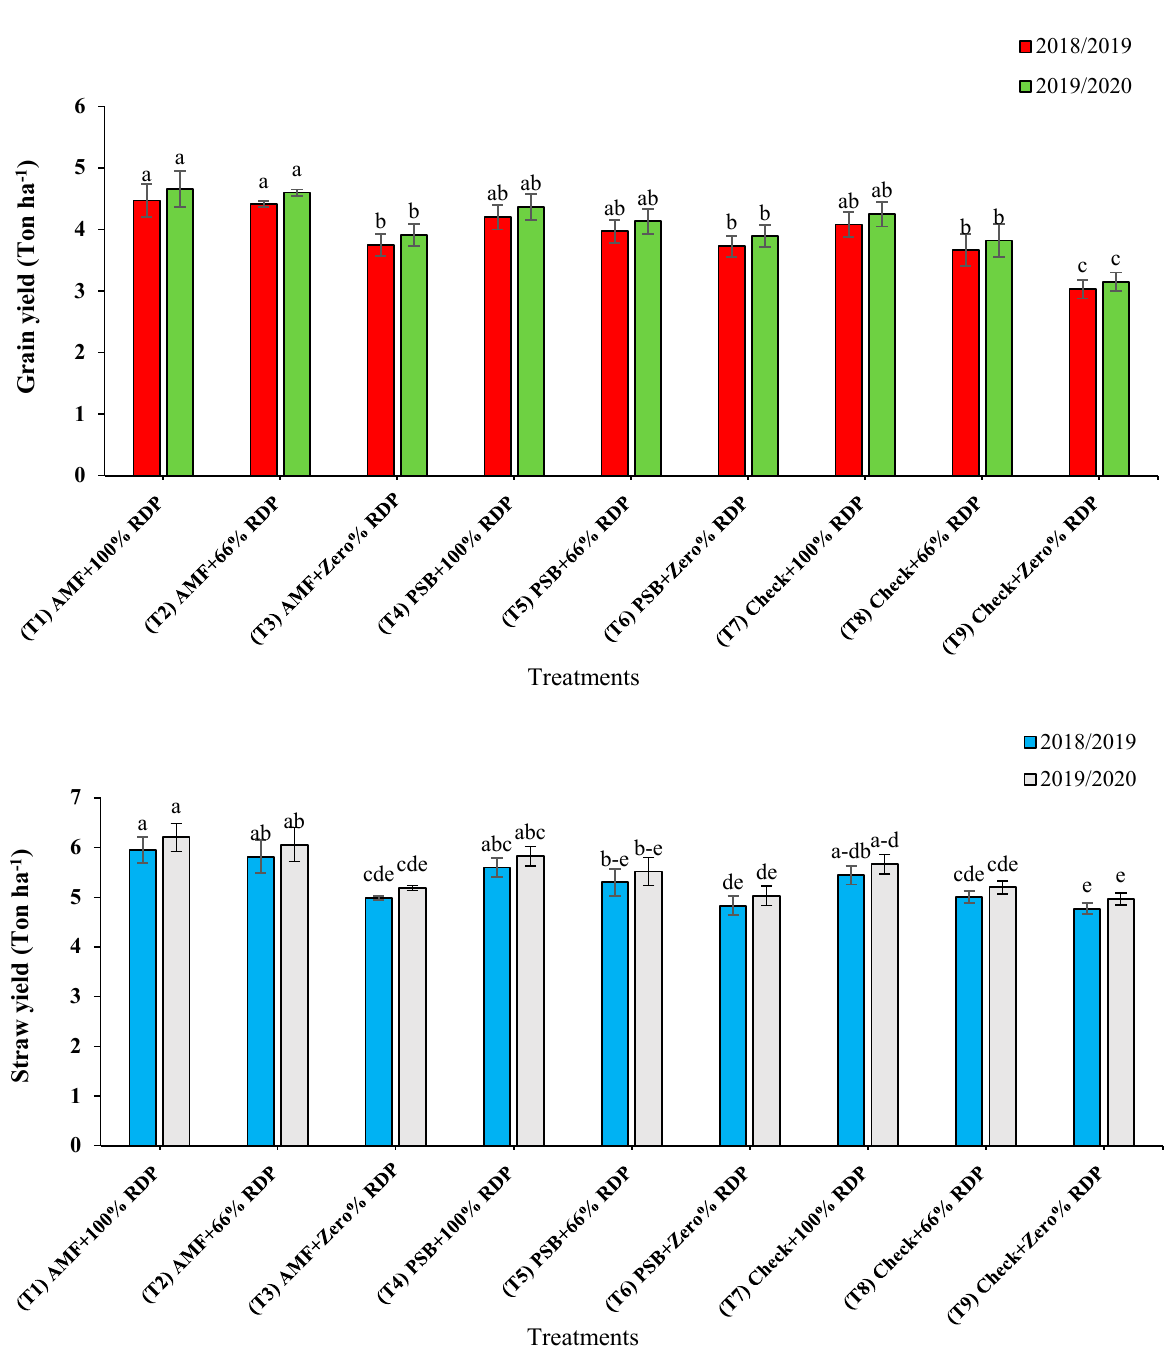
Figure 1. Grain and straw yield (Ton ha − 1 ) of barley Giza 123 cultivar were influenced by the treatment of arbuscular mycorrhizal fungi (AMF), phosphate-solubilizing bacteria (PSB), and different percentages of the recommended dose of phosphorus fertilizers (RDP) in the 2018/2019 and 2019/2020 seasons. Different letters indicate significant differences at p ≤ 0.05 according to Duncan’s multiple range test.